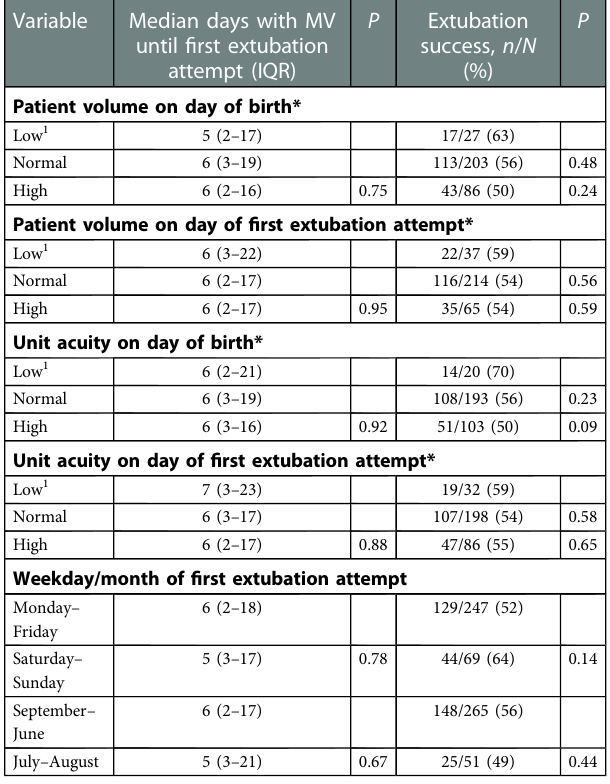
TABLE 2 The association of patient volume, unit acuity, and weekdays with duration of mechanical ventilation and extubation success, n =316. Variable